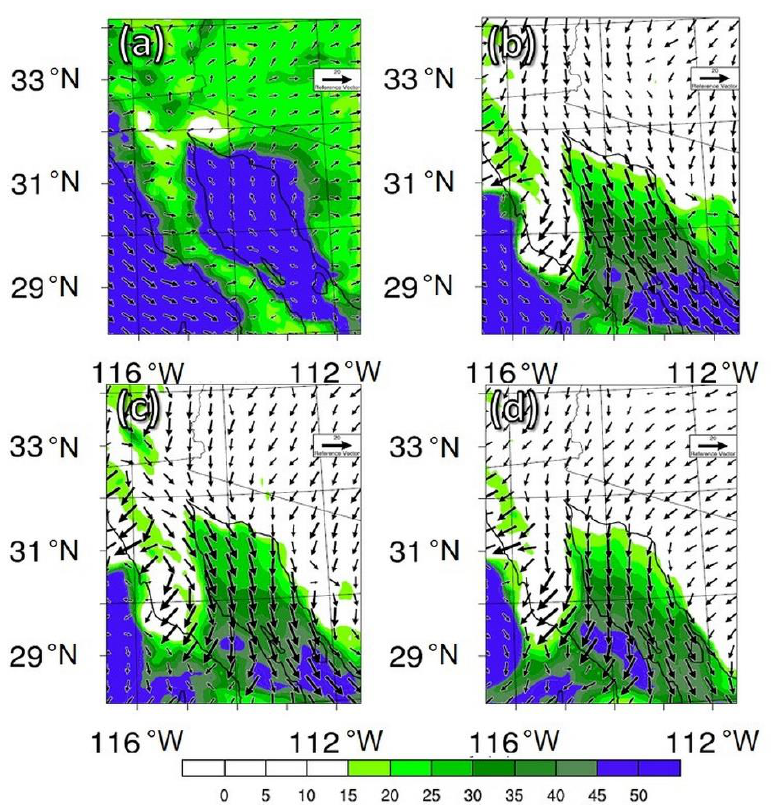
Figure 5. Relative humidity (%) and wind vectors with a magnitude reference of 20 m/s at surface level in domain 1. (a) 00:00 UTC on October 21, (b) 00:00 UTC on October 22, (c) 04:00 UTC on October 22 and (d) 22:00 UTC on October 22.